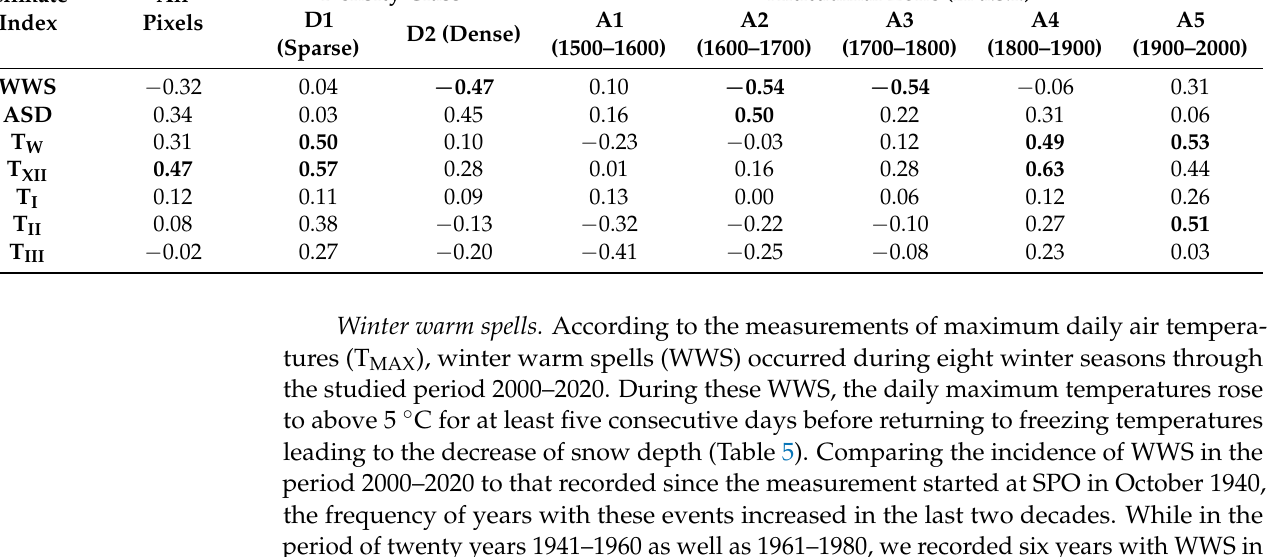
Table 4. Partial correlations between inter-annual differences of P. mugo NDVI and the winter climate indices, while controlling for the effects of summer temperature T S . The significant correlation with p < 0.05 is in bold.